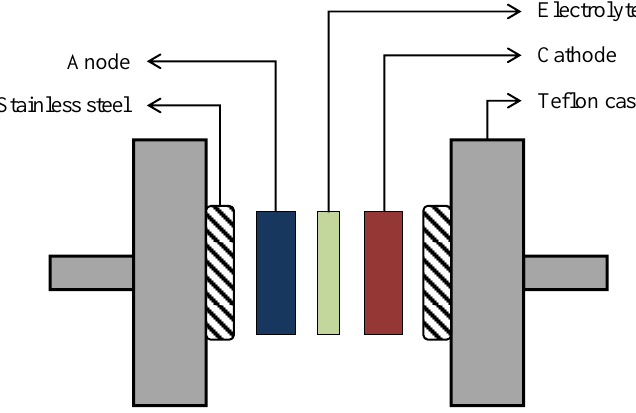
Figure 1. Schematic illustration of the electrolyte–electrodes arrangement for TNM and LSV studies.